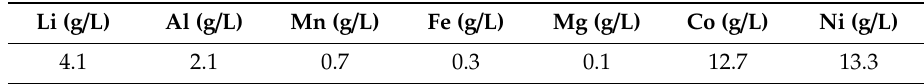
Table 3. Concentrations of the metals in the leaching liquor, which was used for the subsequent precipitation